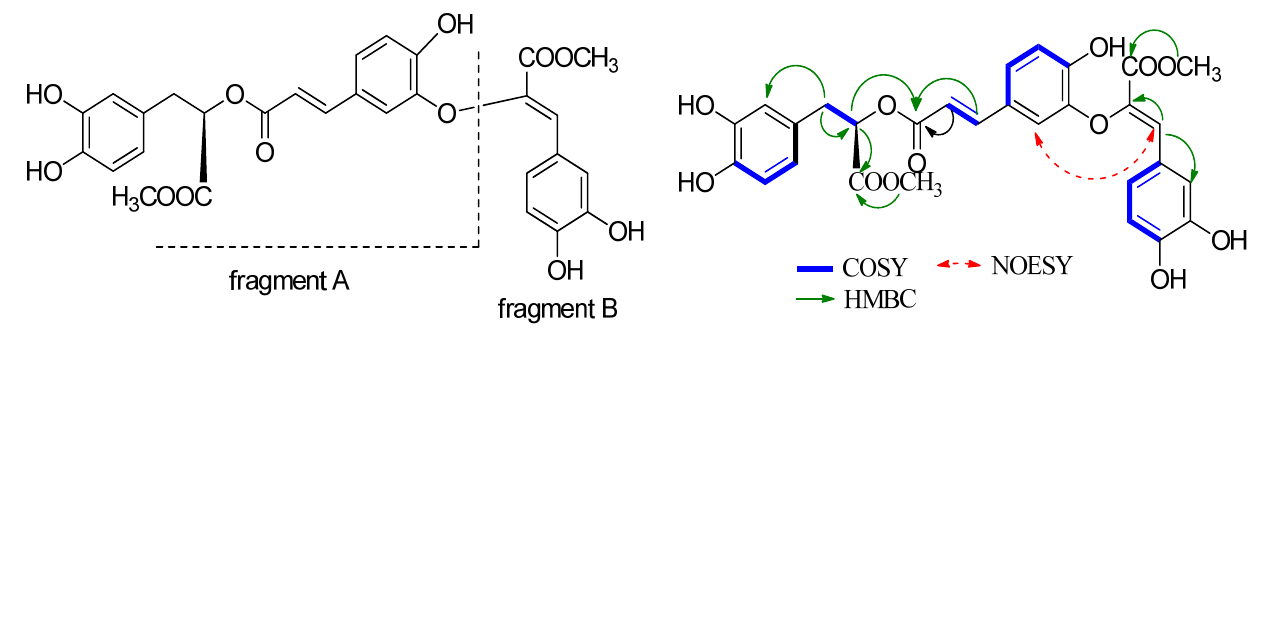
Figure 1. Structure and selected HMBC, COSY and NOESY correlation of 1